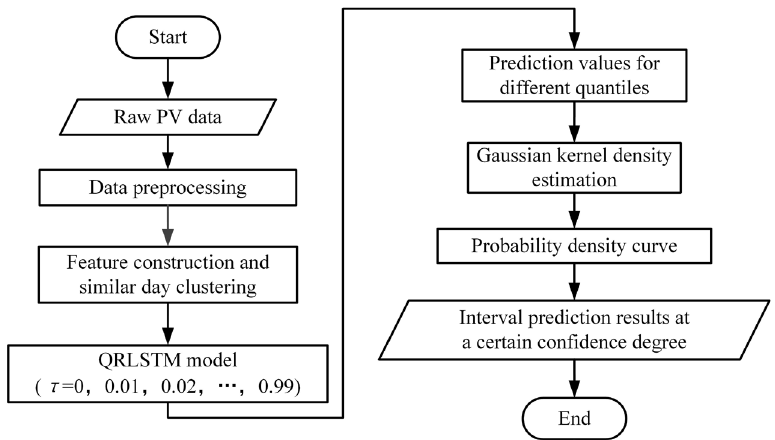
Figure 2. QRLSTM prediction flowchart.